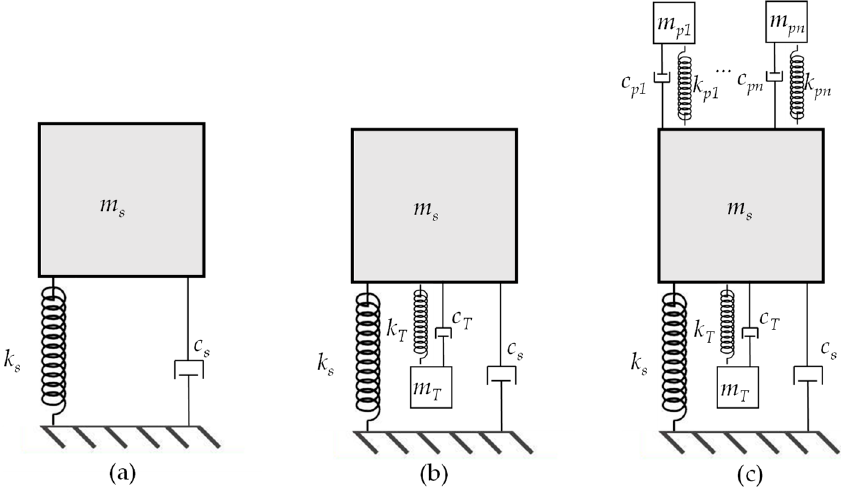
Figure 2. Mass-spring-damper systems: ( a ) primary system; ( b ) coupled structure-TMD system; and ( c ) coupled pedestrian-structure-TMD system.